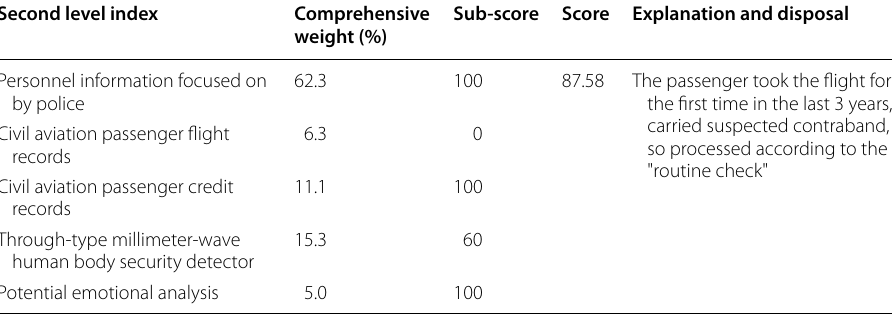
Table 12 Risk assessment results and disposal methods of case